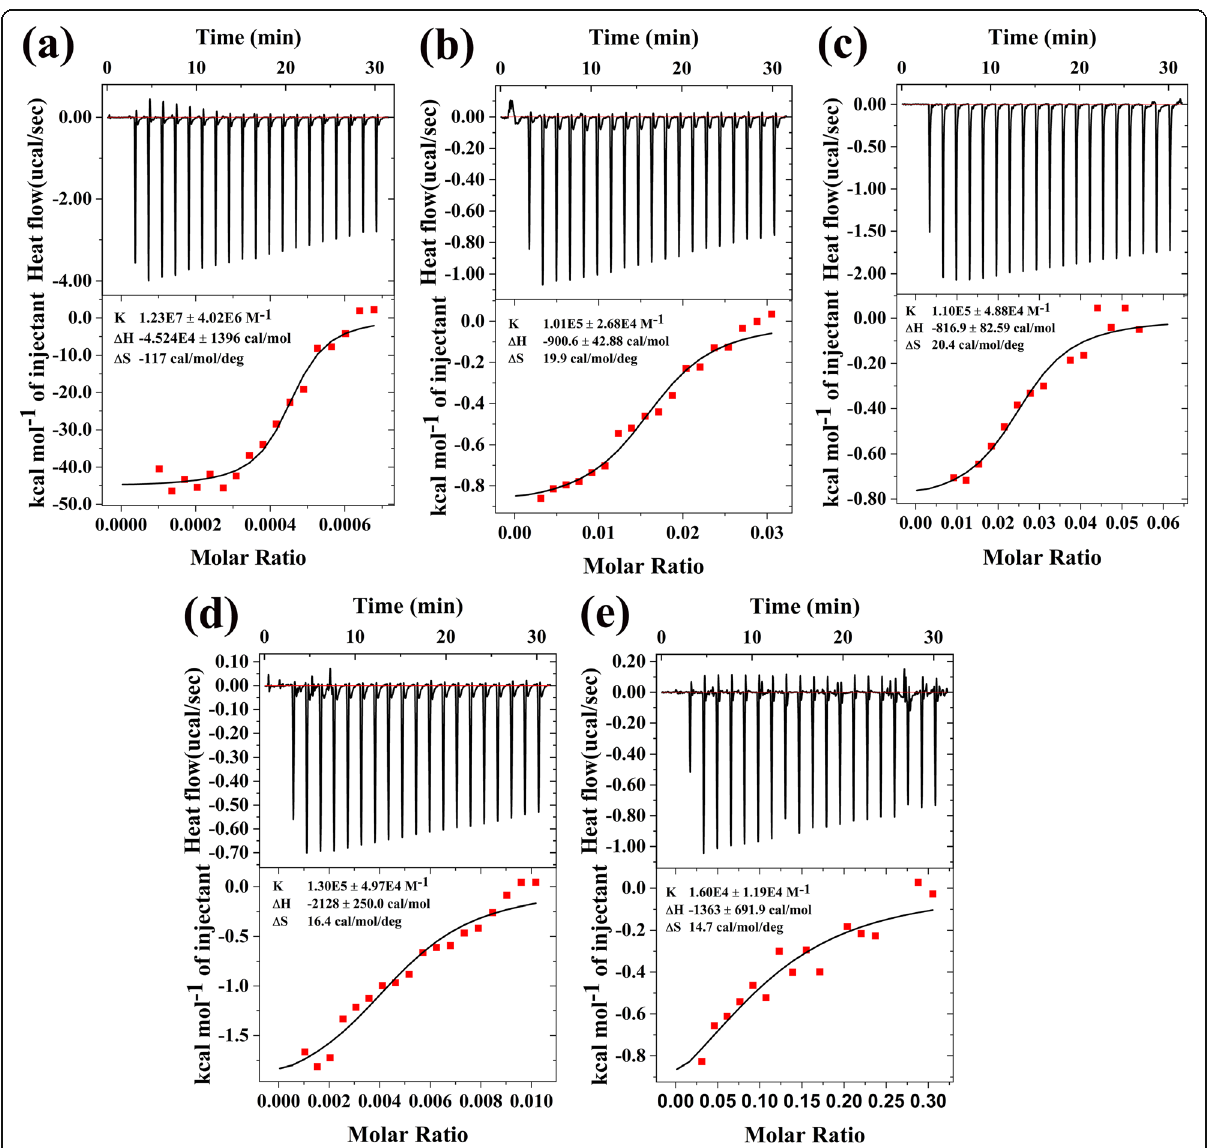
Fig. 4 Isothermal titration curves of Collagen peptides (CPs) solution (0.05 mM) to 4-EP (15.00 mM, a ), CPs solution (1.50 mM) to phenol (10.00 mM, b ), CPs solution (1.50 mM) to guaiacol (5.00 mM, c ), CPs solution (0.50 mM) to 4-EG (10.00 mM, d ) in 52 % ( V/V ) ethanol solution, and CPs solution (1.50 mM) to pure 52 % ( V/V ) ethanol solution ( e